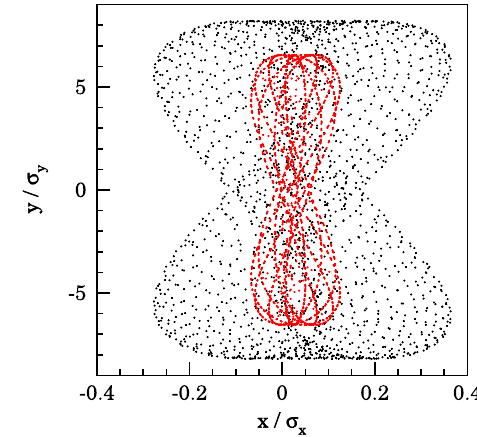
FIG. 14. Resonant orbits for particles having longitudinal momentum δ p=p ¼ 2 σ δ p=p , and z ¼ 0 . In the simulation the longitudinal motion is kept